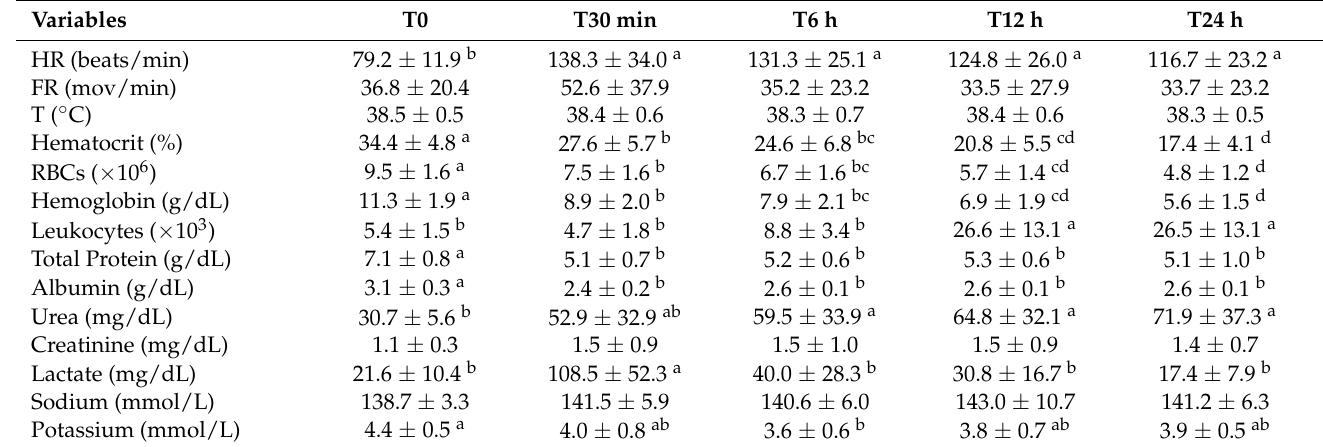
Table 1. Clinical, hematological, and biochemical variables of sheep following acute blood